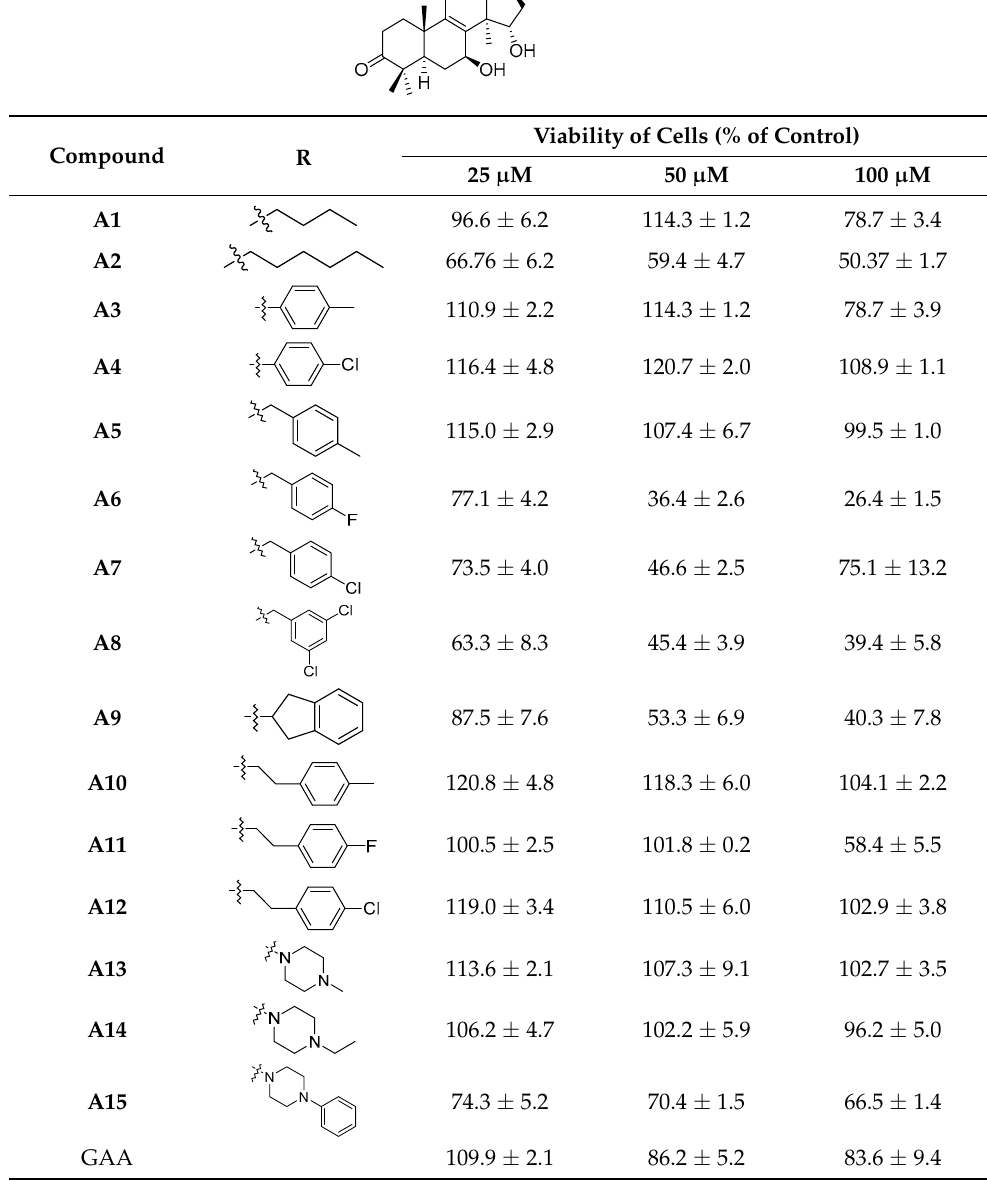
Table 1. The viability of MCF-7 breast cancer cells. Mean values ± SD from three independent experiments ( n = 3) performed in duplicate are presented.